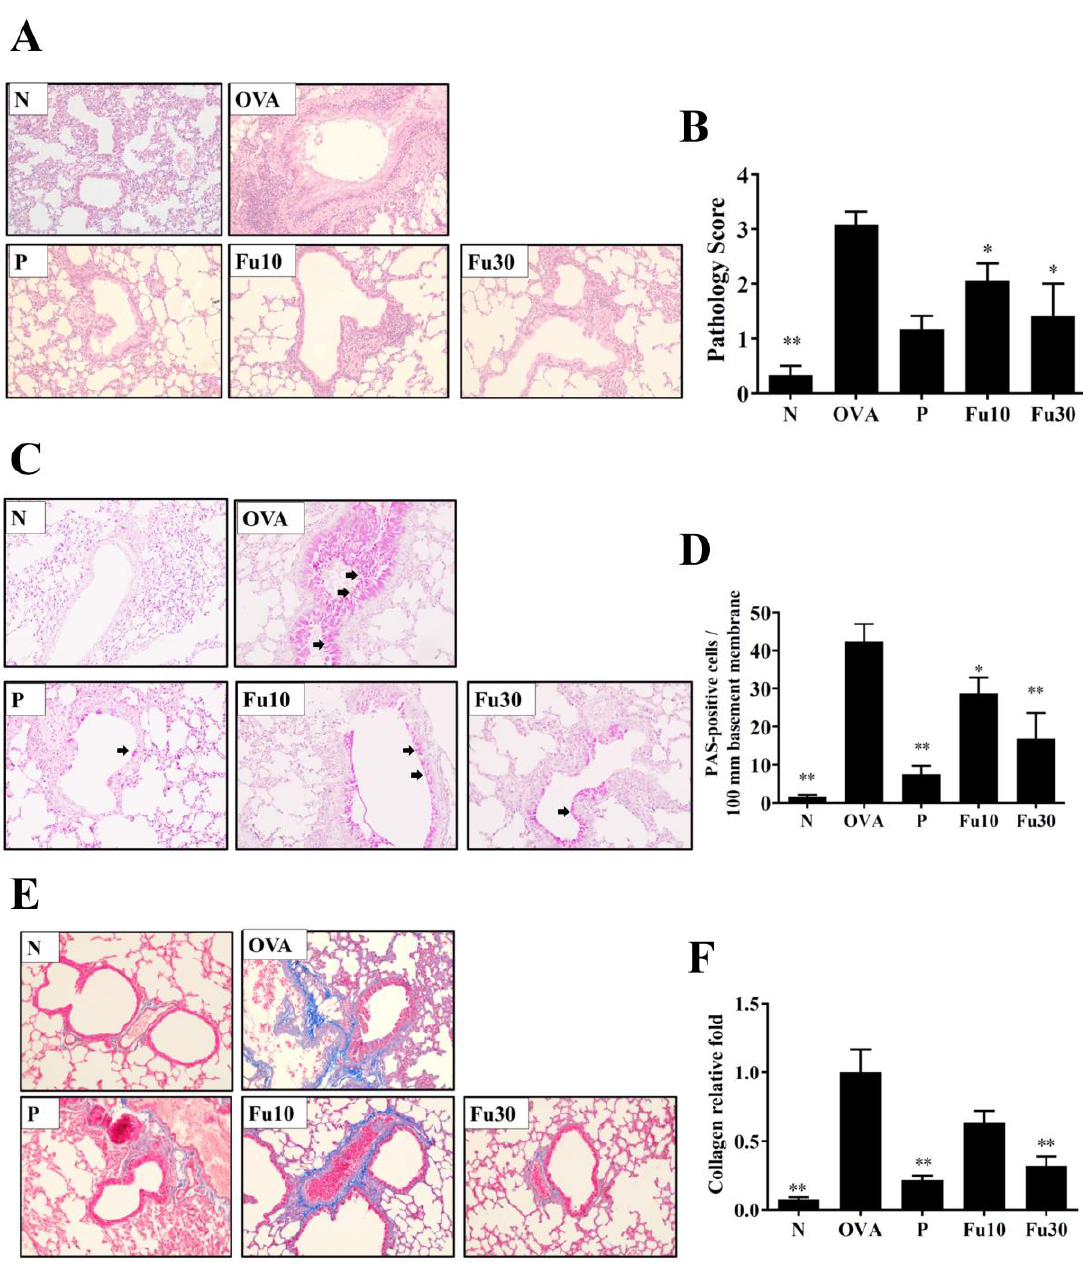
Figure 7. The effects of fucoxanthin (Fu) on asthmatic lung tissue. Histological sections of lung tissues from normal (N) and OVA-stimulated (OVA) mice with or without Fu (10 or 30 μM ) treatment. ( A ) Fu reduced eosinophil infiltration. HE stain, 200× magnification. ( B ) Inflammation was scored by a pathological evaluation of inflammatory cell infiltration in lung sections. ( C ) PAS-stained lung sections show goblet cell hyperplasia. Goblet cells are indicated by arrows. 200× magnification. ( D ) Results were expressed as the number of PAS- positive cells per 100 μm of the basement membrane. ( E ) Lung sections were stained with Masson’s trichrome stain to detect collagen expression. 200× magnification. ( F ) Quantitative analysis of collagen in lung sections. Three independent experiments were analyzed. Data are presented as mean ± SEM. * p < 0.05, ** p < 0.01 compared to the OVA control group. 10 mg/kg and 30 mg/kg fucoxanthin were named as Fu10 and Fu30, respectively. 5 mg/kg prednisolone was named as P.